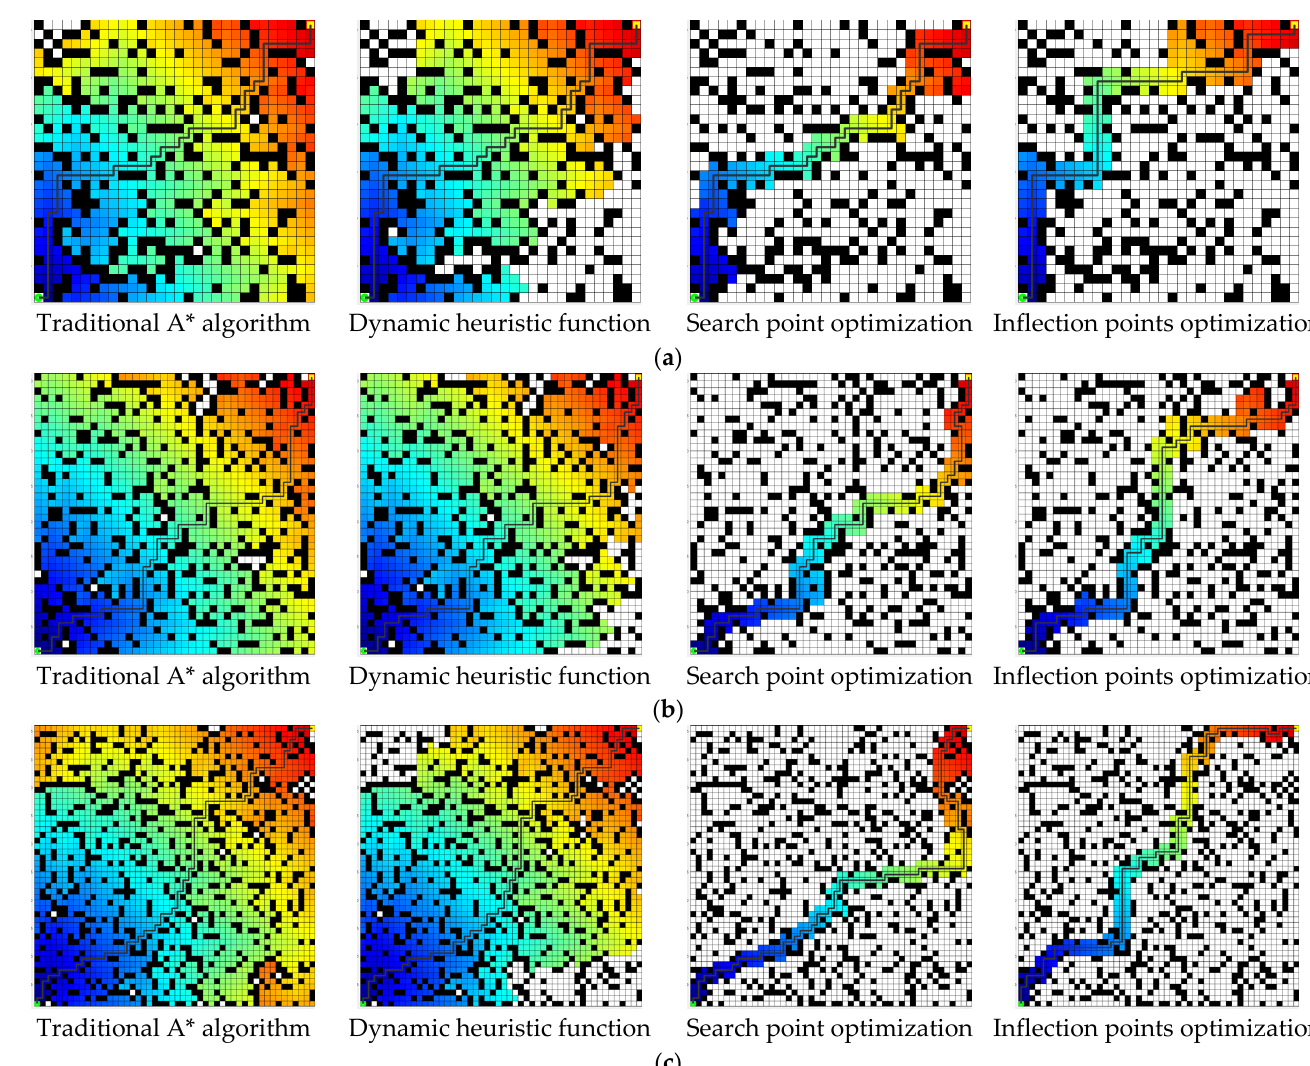
Figure 10. Path planning trajectories for different environments and optimization steps: ( a ) Environments 1; ( b ) Environ- ments 2; ( c ) Environments 3. Table 5. Algorithm performance for different environments and optimization steps.